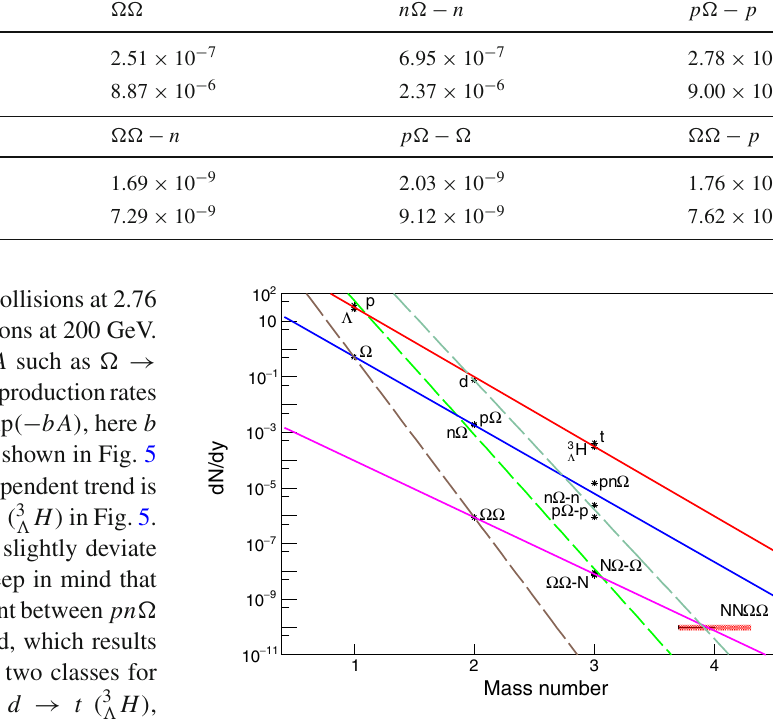
Fig. 5 Theexponentialdecayrelationof dN / dy versustheconstituent mass number ( A ) for Pb + Pb collisions at 2.76 TeV. There are basically two-class production chains, namely the first class: N → d → t ( 3 (cid:2) H ) (red), (cid:3) → N (cid:3) → N N (cid:3) (blue), (cid:3)(cid:3) → N (cid:3)(cid:3) (pink), and the second class: N → N (cid:3) → N (cid:3)(cid:3) (green), (cid:3) → (cid:3)(cid:3) (brown) and d → N (cid:3) N → N N (cid:3)(cid:3) (light green) chains. These lines show the relation dN / dy ∼ exp ( − bA ) , where b = 5.78 (red), 5.68 (blue), and 4.70 (pink) for the first class, and 11.1 (green), 13.3 (brown) and 10.7 (light